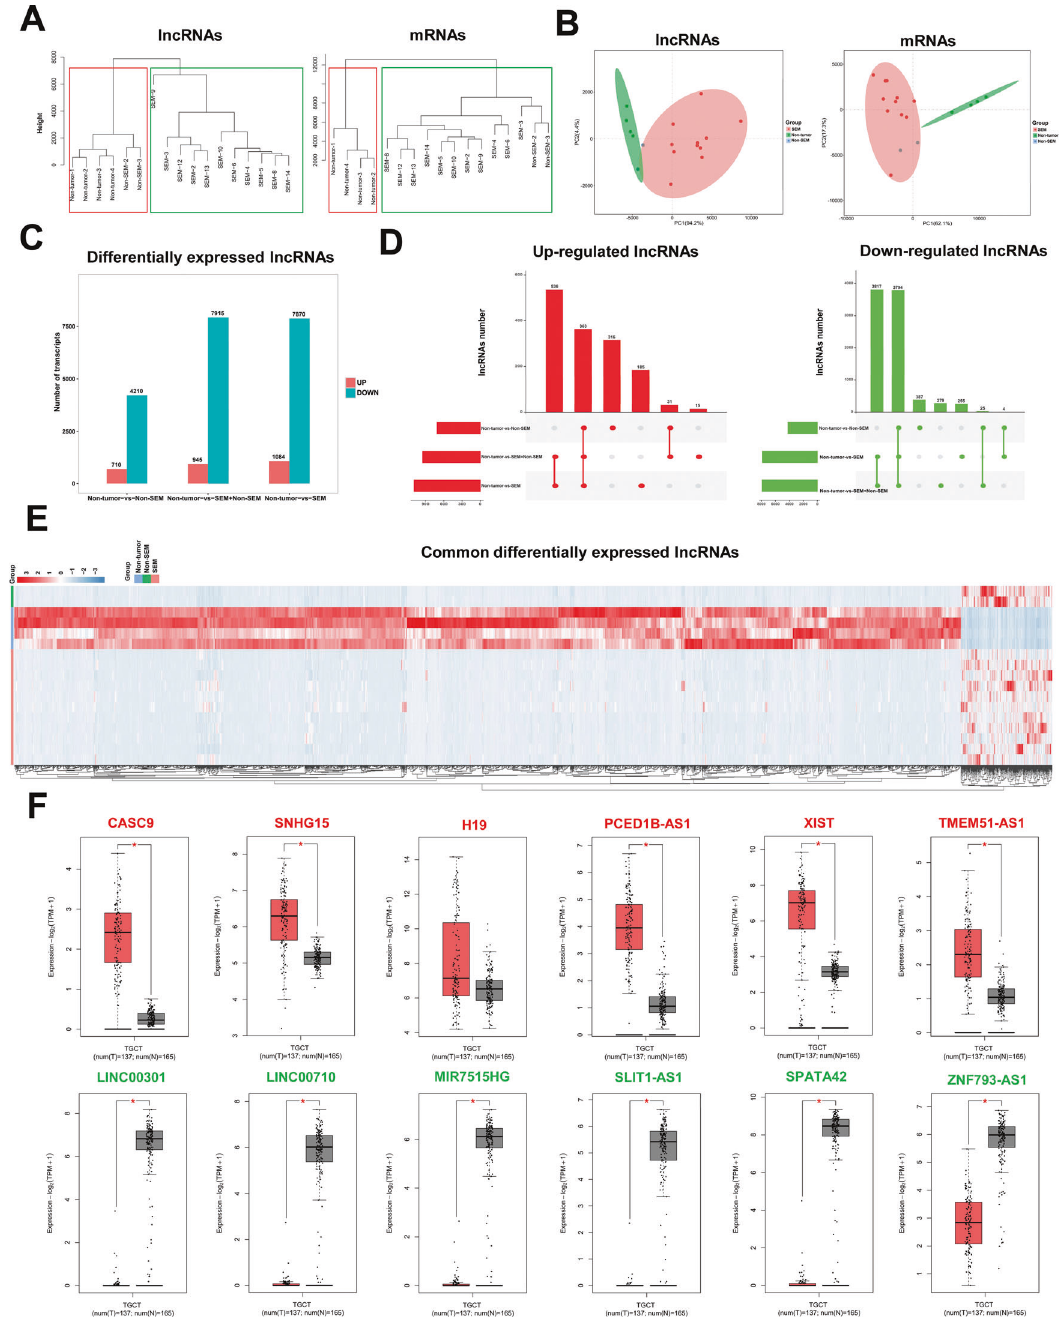
Fig. 2 LncRNAs are signi fi cantly differentially expressed in TGCT. A Hierarchical clustering plots based on sample lncRNA expression (left) and sample mRNA expression (right). B PCA analysis plots based on sample lncRNA expression (left) and sample mRNA expression (right). C Histogram of DElncRNAs number between groups. D Upset plots of the distribution of upregulated lncRNAs (left) and downregulated lncRNAs (right) in each group. E Heatmap showed the common differentially expressed lncRNAs of seminoma and non-seminoma compared with adjacent tissues. F Veri fi cation of the common DElncRNAs in GEPIA